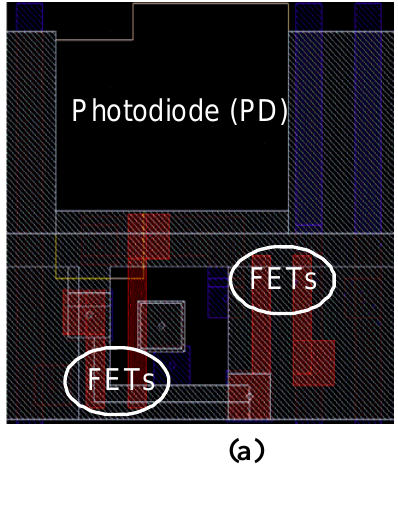
Figure 3. Layouts of the (a) optical sensing pixel and (b) passive electric sensing pixel (capacitive coupling) (adapted from